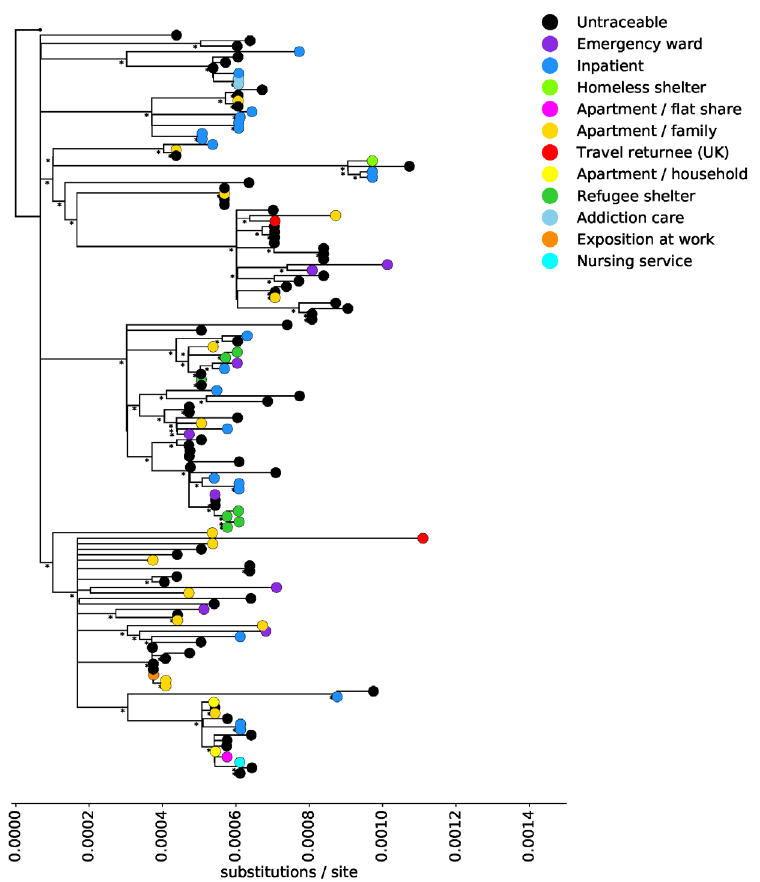
Figure 1. Phylogenetic tree of SARS-CoV-2 sequences: Maximum likelihood tree showing the phylogenetic relationship among the sequences generated in this study. Tips are colored by infection route. Nodes with bootstrap support less than 20 are collapsed or marked with an asterisk if bootstrap support is above 70. The tree was inferred with IQTree using a GTR substitution model and 1000 ultrafast bootstrap replicates, and is rooted with the Wuhan-Hu-1 sequence (GenBank accession no MN908947.2).